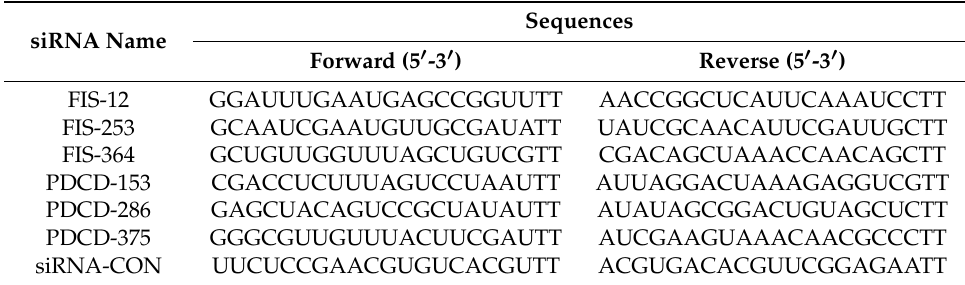
Table 2. Sequences of small interfering